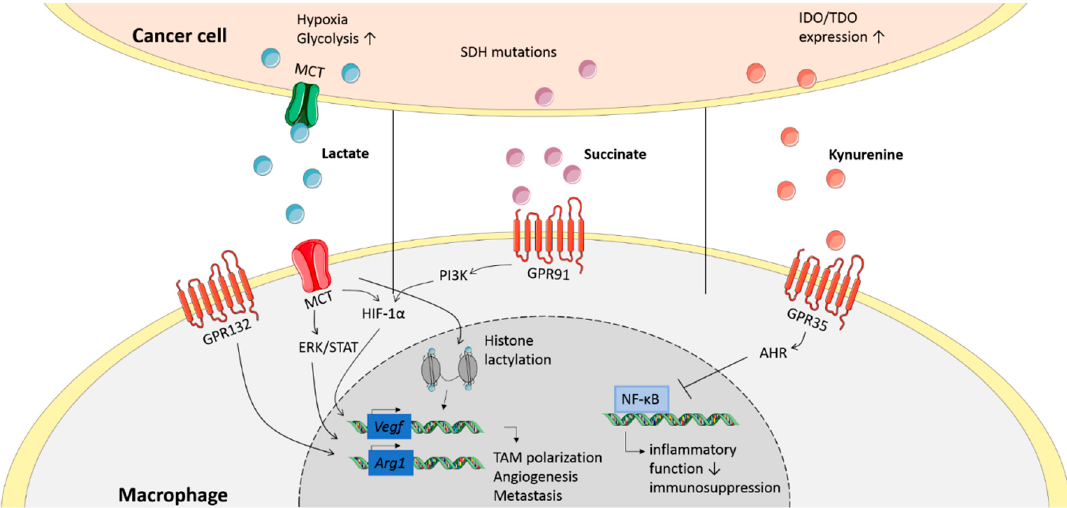
Figure 2. Signaling of oncometabolites in macrophages. Cancer cells secrete various oncometabolites, of which lactate, succinate and kynurenine are shown here. These oncometabolites signal through receptors or get internalized by transporters on the membrane of macrophages. This inhibits inflammatory functions and induces expression of genes related to an anti-inflammatory phenotype.